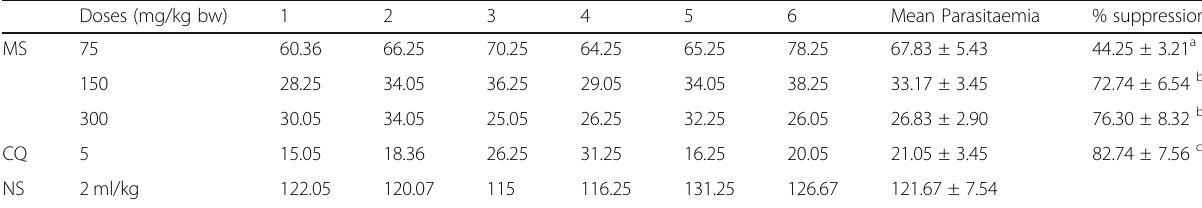
Table 2 Antiplasmodial activity of purified fraction of M. senegalensis leaf against Plasmodium berghei Infected mice Doses (mg/kg